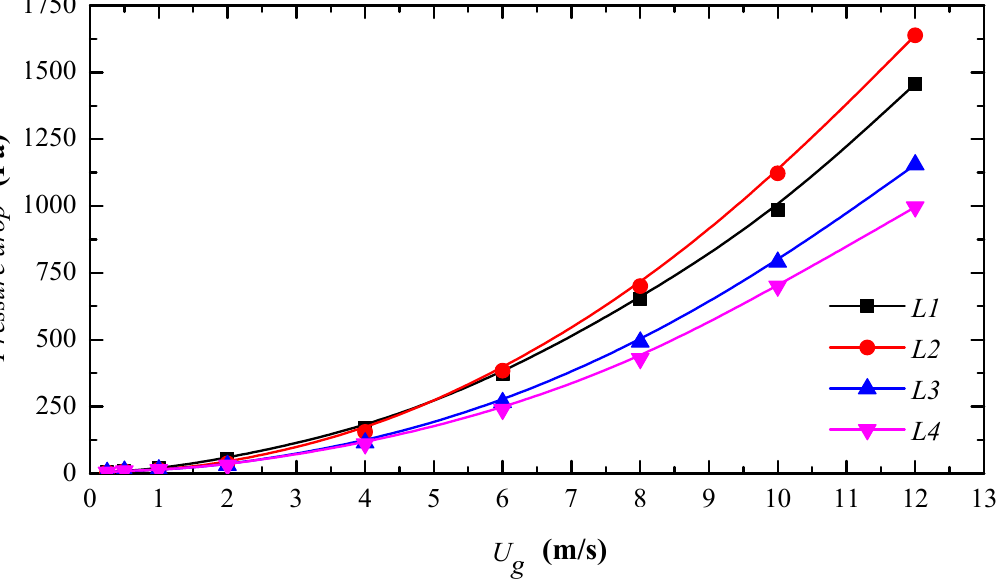
Figure 10. The variation of pressure drop versus inlet velocity in different wavelengths. However, as shown in Figure 11, it is observed that at low Reynolds numbers, the friction factor increases with the increase of wavelength, which may be due to the increasing turbulence dissipation of the area vortex and high loss due to friction resistance. However, as the Reynolds number increases, the turbulence dissipation ratio contributes more in the pressure drop than that of the friction resistance lead by a large contact surface, thus the range is L4 < L3 < L1 < L2 , same as that of the pressure drop.